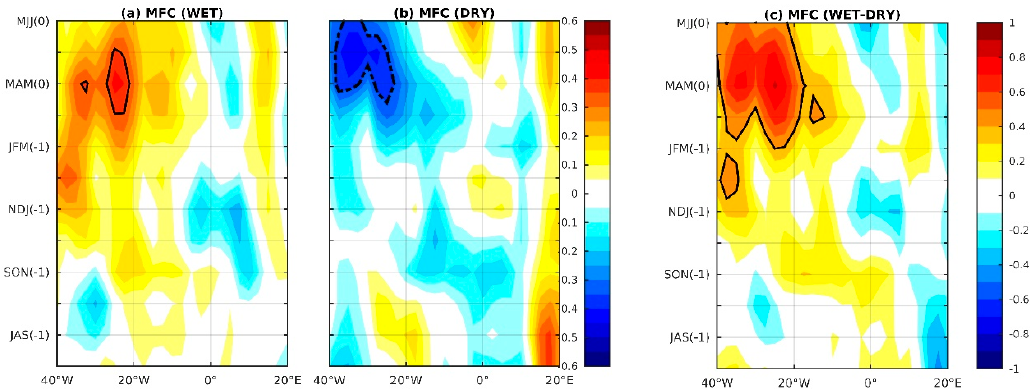
Figure 3. a, b, c, the Same as in Figure 2 ( c , d, e ), but for the gridded vertically integrated